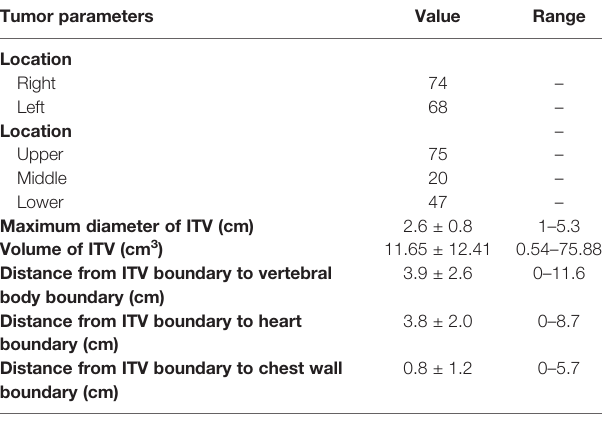
TABLE 2 | Tumor characteristics for patients (n =